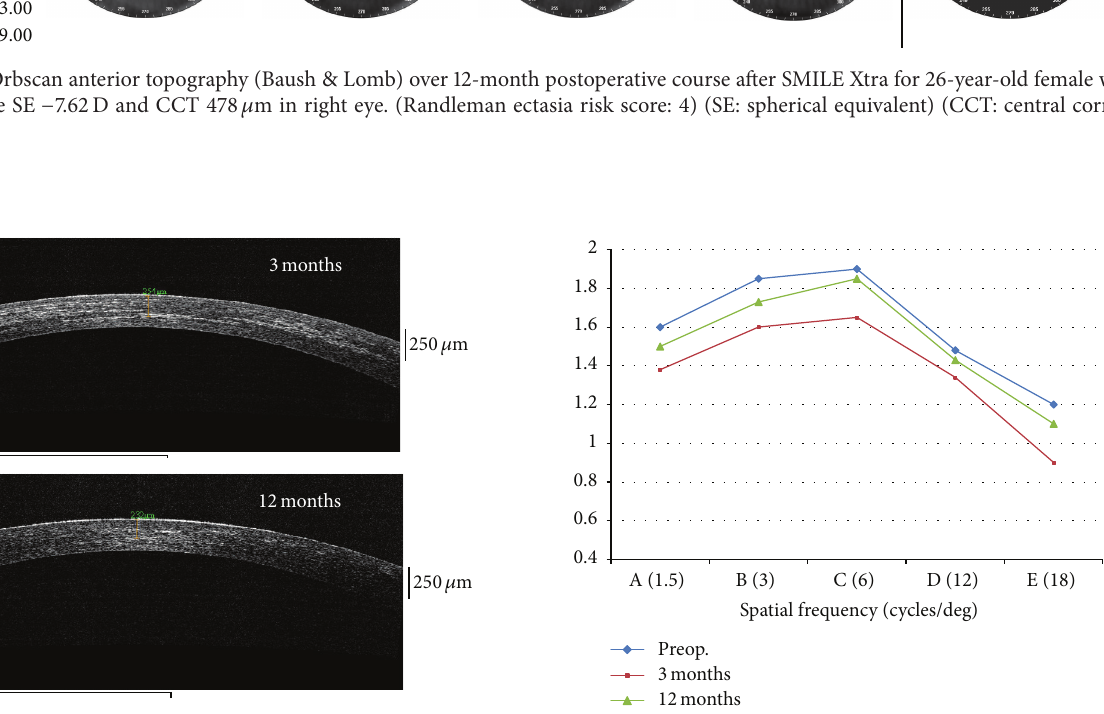
Figure 6: Contrast sensitivity (FACT) at 3 months and 12 months compared to